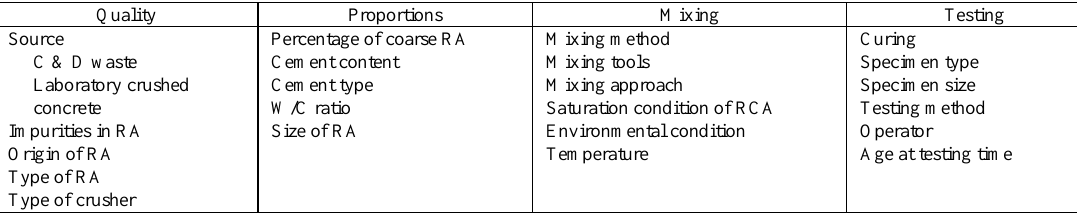
Table 2. Variables affecting the strength of